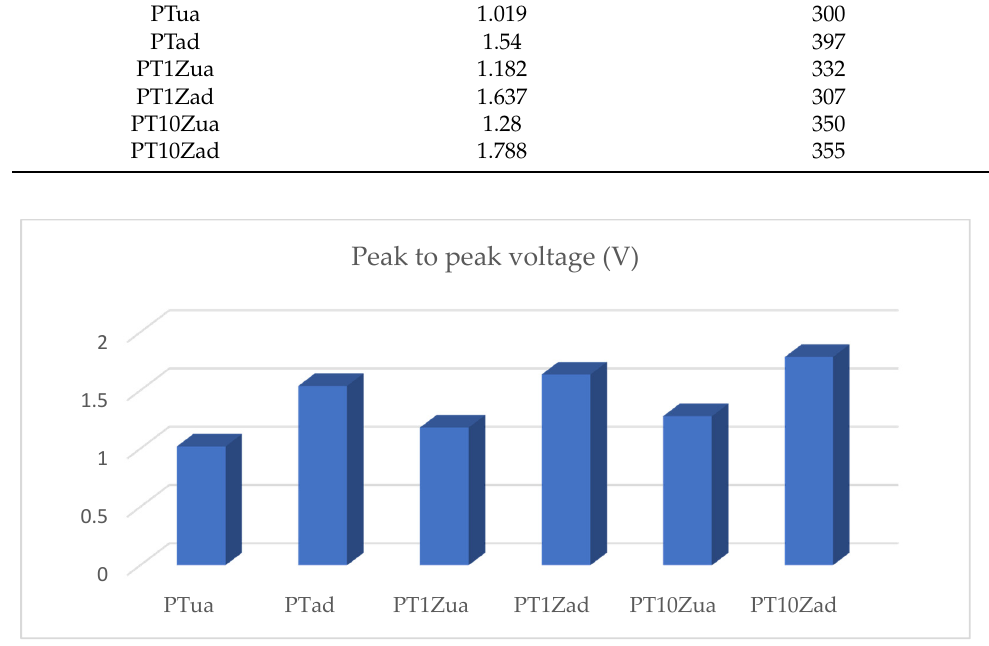
Figure 8. Histogram for peak-to-peak voltage.